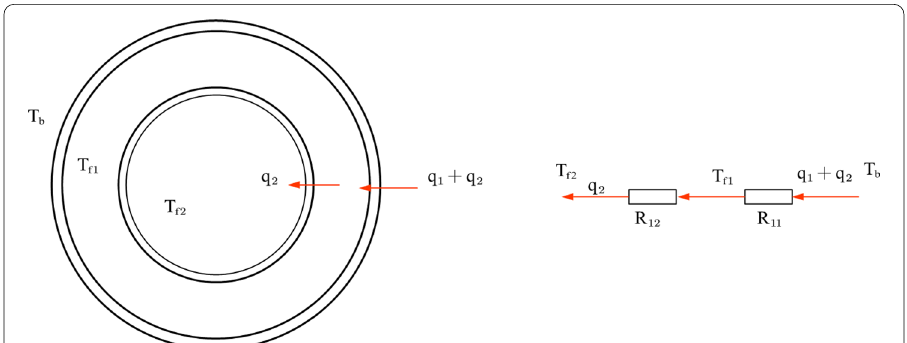
Fig. 5 Cross section of annular pipe borehole and the corresponding thermal